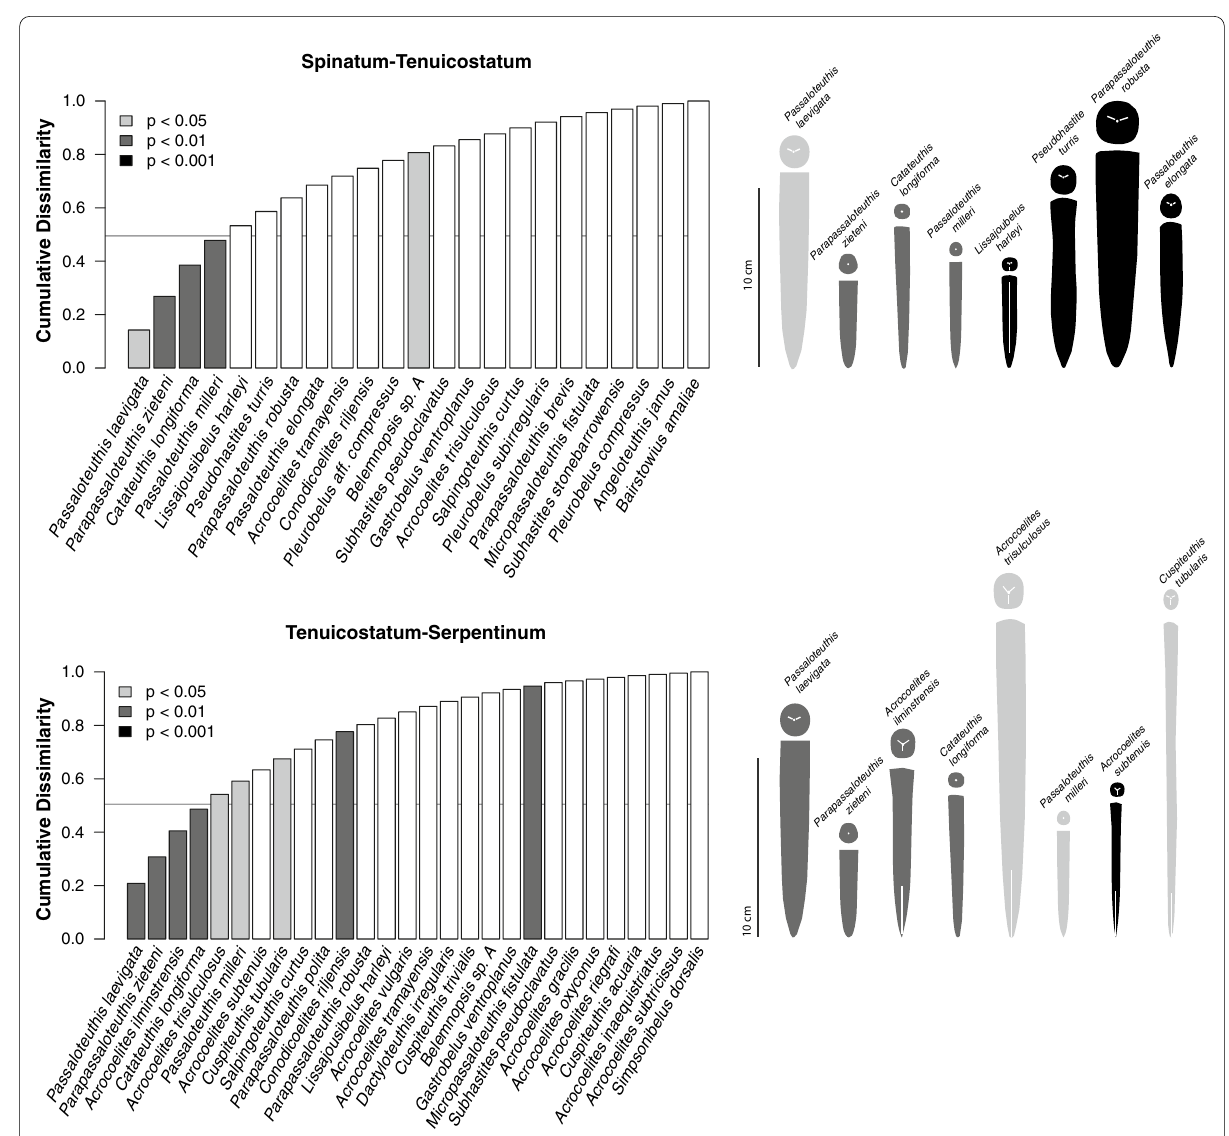
Fig. 4 Results of the SIMPER analyses when comparing the Spinatum–Tenuicostatum as well as the Tenuicostatum–Falciferum Zones. Eight species explaining the largest shifts in dissimilarity are